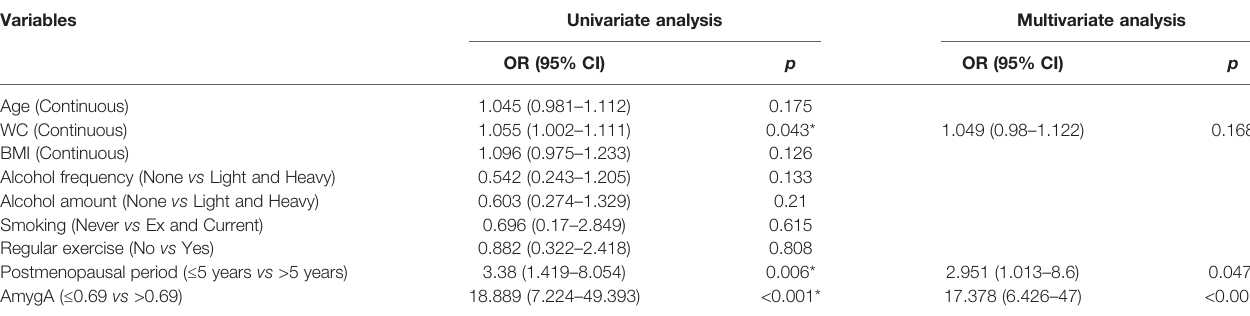
TABLE 3 | Uni- and multivariate logistic regression analyses for the associated predictors of osteoporosis in postmenopausal women. Variables Univariate analysis Multivariate analysis OR (95% CI) Age